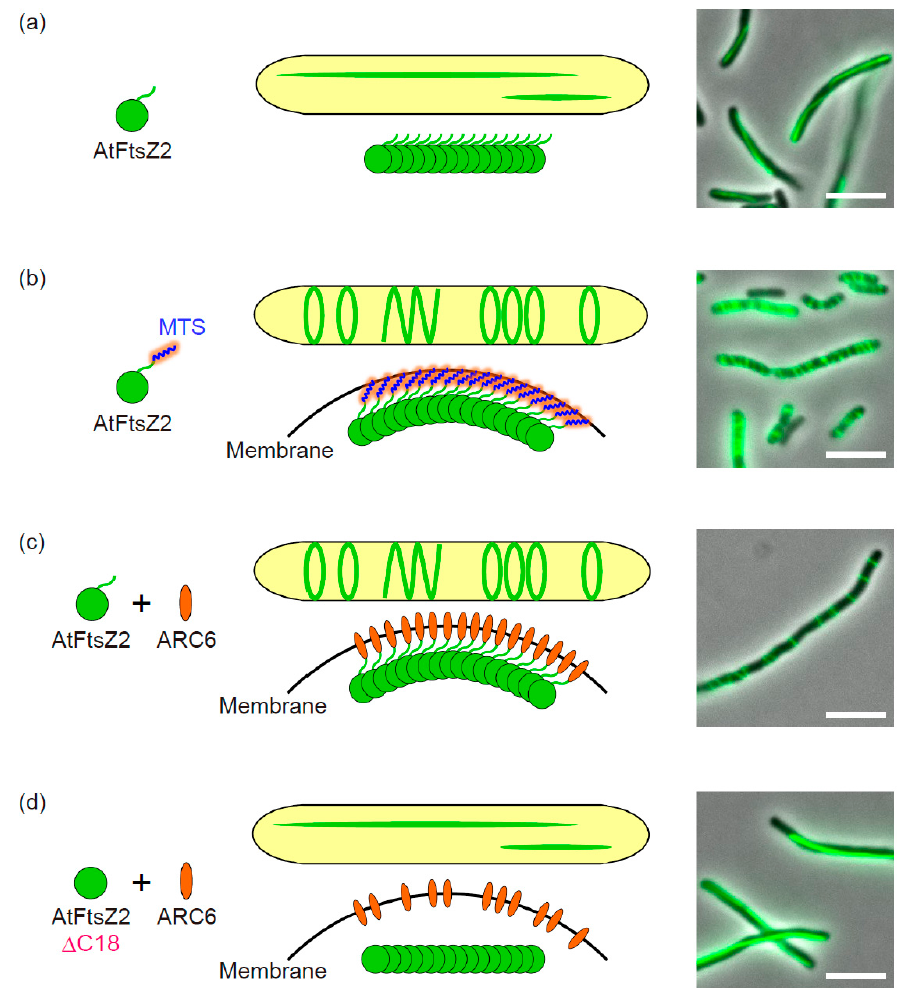
Figure 1. The formation of Z ring-like structures of Arabidopsis chloroplast FtsZ2 in the bacterial heterologous expression system. Schematic illustration of the proposed molecular behavior of chloroplast division-related components in E. coli cells and its merged microscopic image of phase-contrast and GFP are shown when expressing ( a ) super folder GFP (sfGFP)-AtFtsZ2, ( b ) sfGFP-AtFtsZ2-2MTS, ( c ) sfGFP-AtFtsZ2, and Accumulation and Replication of Chloroplasts 6 (ARC6) and ( d ) sfGFP-AtFtsZ2 ∆ C18 (C-terminal 18-residue truncated form of AtFtsZ2) and ARC6. E. coli cells were grown in L broth (1% bactotryptone, 0.5% yeast extract, 0.5% NaCl) to the stationary phase at 22 ◦ C. Scale bars: 5 µ m. MTS: membrane-targeting sequence. To reduce the complexity in the diagrams, bundling of the FtsZ2 filaments was omitted.